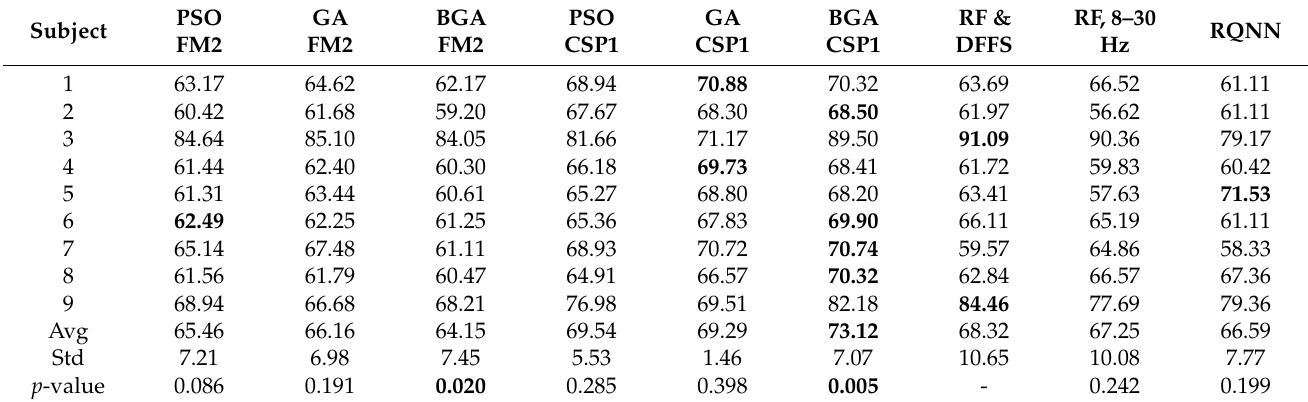
The table is comparing first and second model scenarios using algorithms. FB I & J means that the new signal is the combination of filter bank I with J. Ch 12 and Ch 8 mean Channel 12 and Channel 8, respectively. Table 18. The best results of different methods for feature selection (along with feature extraction, feature reduction, channels, etc.) on two channels 8 and 12 by combining different select